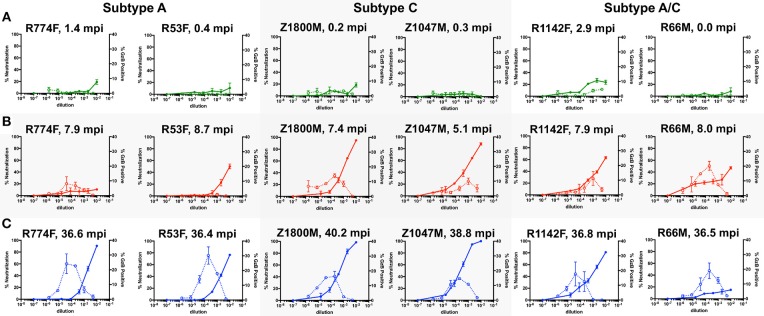
Evaluation of longitudinal nAb and ADCC capacity of plasma samples against the autologous T/F Env. nAb and ADCC activity in plasma collected at chronologic time points 1 (A, 0.87 months post infection), 2 (B, 7.5 months), and 3 (C, 37.5 months); All graphs show the percent neutralization of autologous T/F Env pseudovirus (closed symbols with solid line, left Y-axis) and percentage of fluorogenic GzB substrate positive CEM.NKr.CCR5 cells coated with autologous T/F Env gp120 (open symbols with dashed line, right Y-axis). The subjects are grouped by HIV-1 subtype, which is labeled on the top. The time points shown are 0 to 2.9 months after the first antigen-positive test (green), 5.1–8.7 months after the first antigen positive test (red lines), and 36.4–40.2 months after the first antigen positive test (blue lines). The X-axis indicates the reciprocal dilution of the individual's plasma plotted on a log10 scale. Symbols and error bars represent the mean and standard error of mean, respectively, between at least two replicate experiments for neutralization, and the mean and standard error of mean of independent experiments utilizing cells from two different donors for the GzB assay. Control data for (i) plasma nAb against a negative control VSV-g Env pseudovirus and (ii) GzB mediated by normal human serum against the T/F Env gp120 can be found in Supplementary Figure 2F.